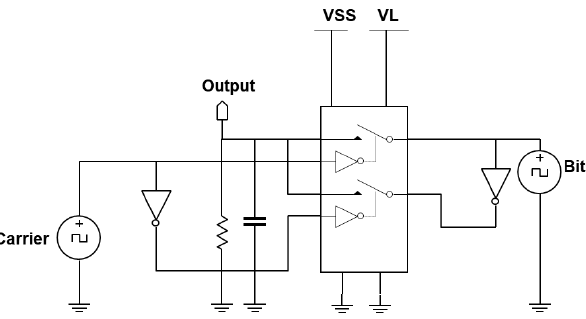
Figure 5. Circuit schematic of the emulated BPSK transmitter.